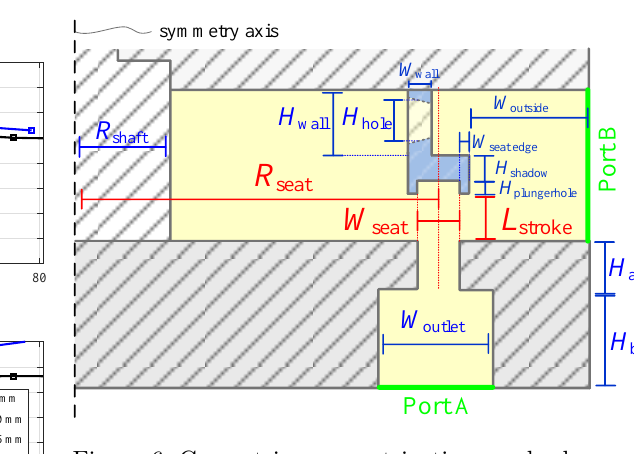
Figure 6: Geometric parametrization used when eval- uating the CFD model. The red are design variables and the blue are design point aux- iliary